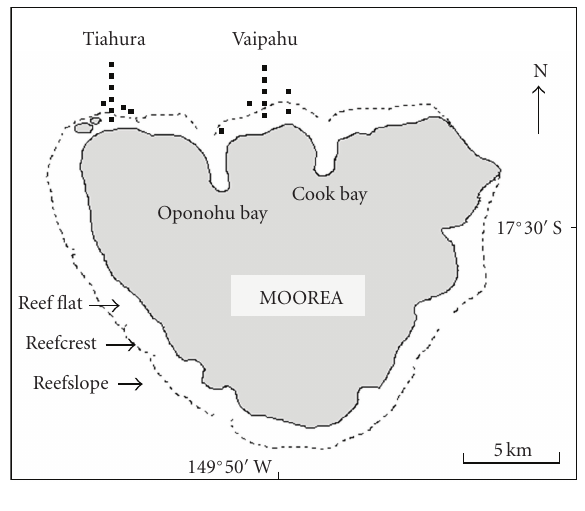
Figure 1: Map of Moorea (17 ◦ 30 (cid:3) S, 149 ◦ 50 (cid:3) W) in the Society Island, French Polynesia, showing the main study sites on the reef flat, reef crest and reef slope at Tiahura (North-West) and Vaipahu (North-East). Dashed lines represent the approximate extent of the reef